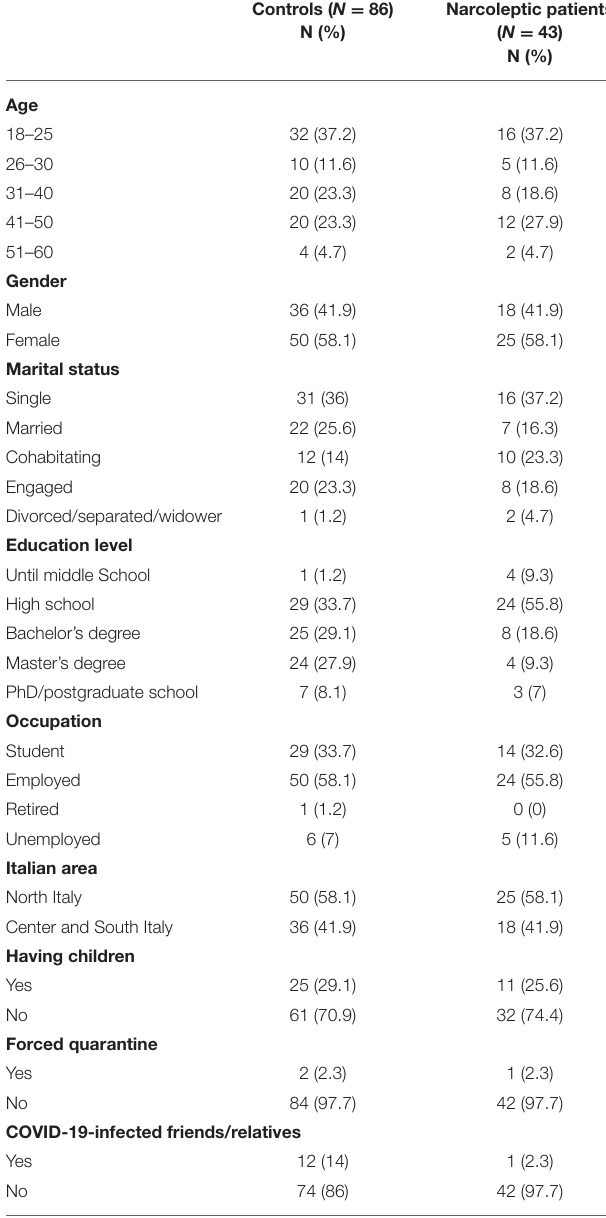
TABLE 1 | Socio-demographic and COVID-19-related